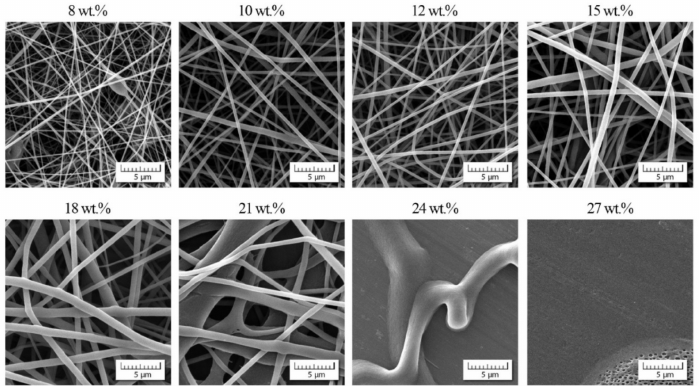
Figure 8. Scanning electron micrographs (SEM) showing the morphology of individual nanofibers for various copolymer concentrations and DMF/acetone ratio